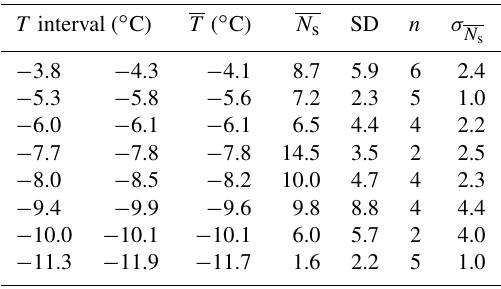
Table A3. The mean ( N s ) and standard deviation (SD) of the num- ber of secondary drops within a specified temperature interval ( T interval) along with the number of experiments ( n ) within the T in- terval, the average degree of supercooling within the temperature interval ( T ) and the error in the sample mean ( σ N s